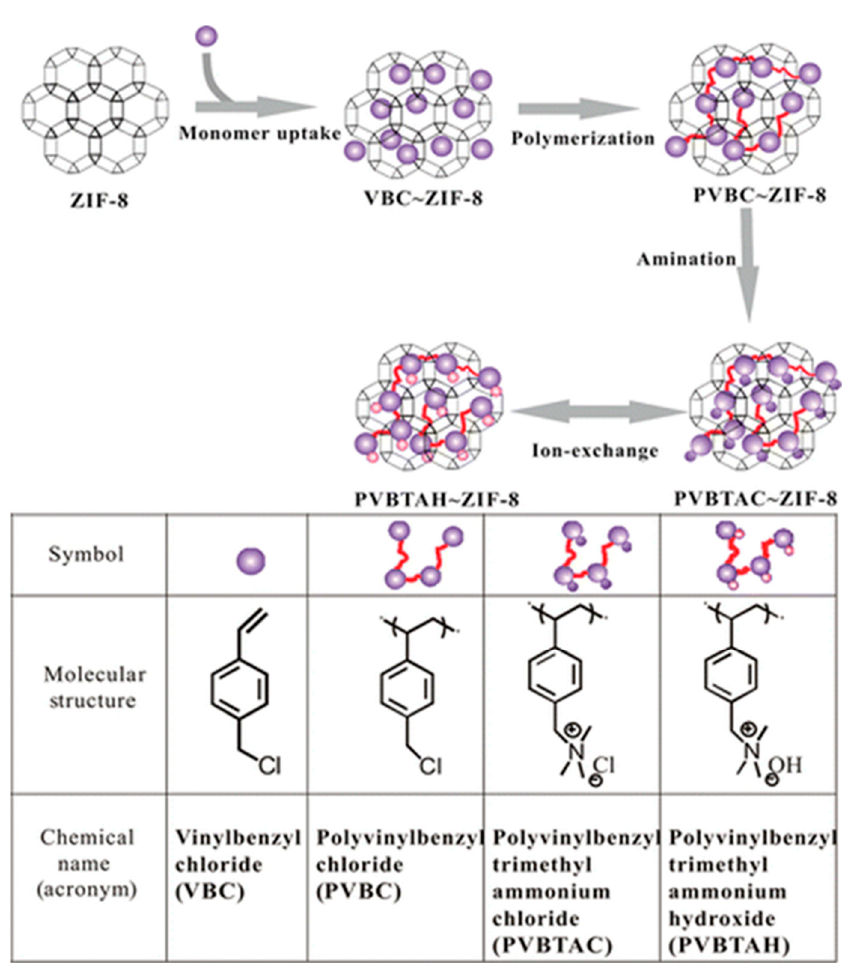
Figure 14. Synthesis of ion ‐ exchange polymer (PVBTAH) inside the porous network of ZIF ‐ 8. Reprinted with permission from Ref. [133]. Copyright (2014) American Chemical Society.